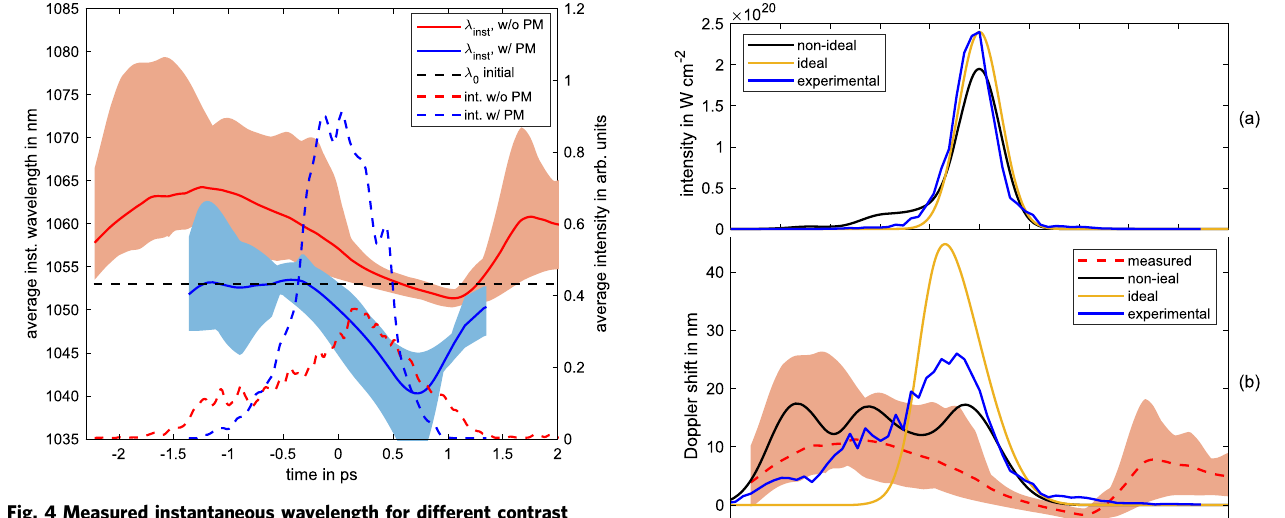
Fig. 4 Measured instantaneous wavelength for different contrast conditions. Comparison of the instantaneous wavelengths and re fl ected laser pulse for the condition with (blue) and without PM (red) and an incoming laser intensity of 10 20 W cm − 2 and 2.4 × 10 20 W cm − 2 , respectively. The solid blue and red lines show the mean value of all shots for each corresponding condition, with the uncertainty, given by the peak- to-valley values, indicated by the shaded areas of the respective color. The dashed blue and red lines indicate the average pulse envelope for each condition normalized to its integral and the dashed black line corresponds to the initial central wavelength.